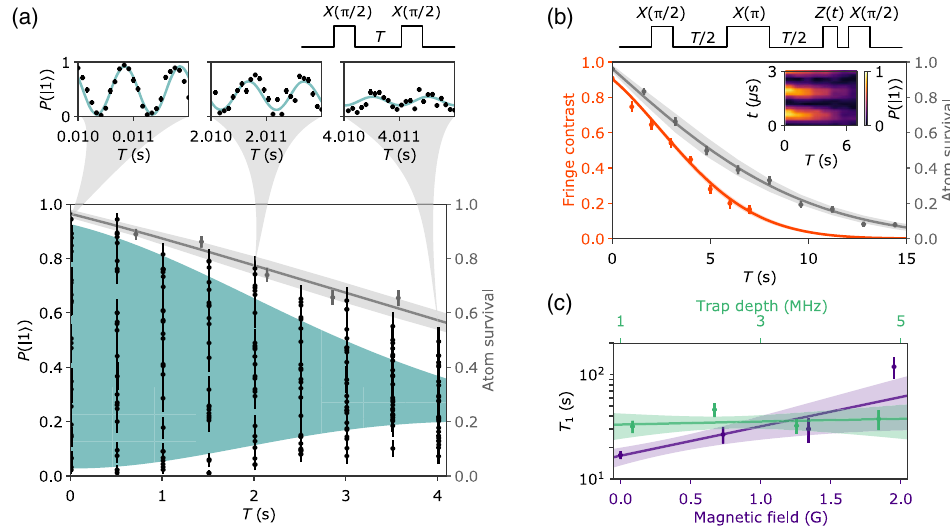
FIG. 4. Qubit coherence. (a) Ramsey experiment. Population of state j 1 i oscillates at the frequency given by the splitting of two ground states. The fit (teal) is a cosine of a single frequency and phase, with an envelope given by the lifetime and Gaussian dephasing. The teal region in the lower plot corresponds to the envelope of the fit shown in the callouts. The T (cid:2) 2 extracted from the fit to the oscillations is 3.7(4) s. The measurement of atom lifetime in tweezers is also plotted (gray), with 1 =e time of 6.42(3) s. The error bars correspond to standard deviations of the binomial distributions given by the measured probabilities. (b) Spin-echo experiment. Inset: population of state j 1 i oscillates with the duration of Z ð t Þ gate applied before the final X ð π = 2 Þ pulse. The contrast of the recorded fringe (orange) decreases with dark time T due to the finite lifetime in tweezers (gray), of 7 . 13 ð þ 6 − 5 Þ s, and decoherence described by a Gaussian decay. The T 2 inferred from the fit is 7.9(4) s. The orange error bars are given by the square root of the covariance matrix diagonal entry corresponding to the fit contrast parameter. (c) Depolarization time. T 1 dependence on applied magnetic field (purple) and tweezer depth (green). T 1 is extended approximately exponentially with increasing bias field, and is invariant with changing tweezer depth. The error bars in (c) are similarly given by the square root of the covariance matrix diagonal entry corresponding to the spin depolarization time parameter of the